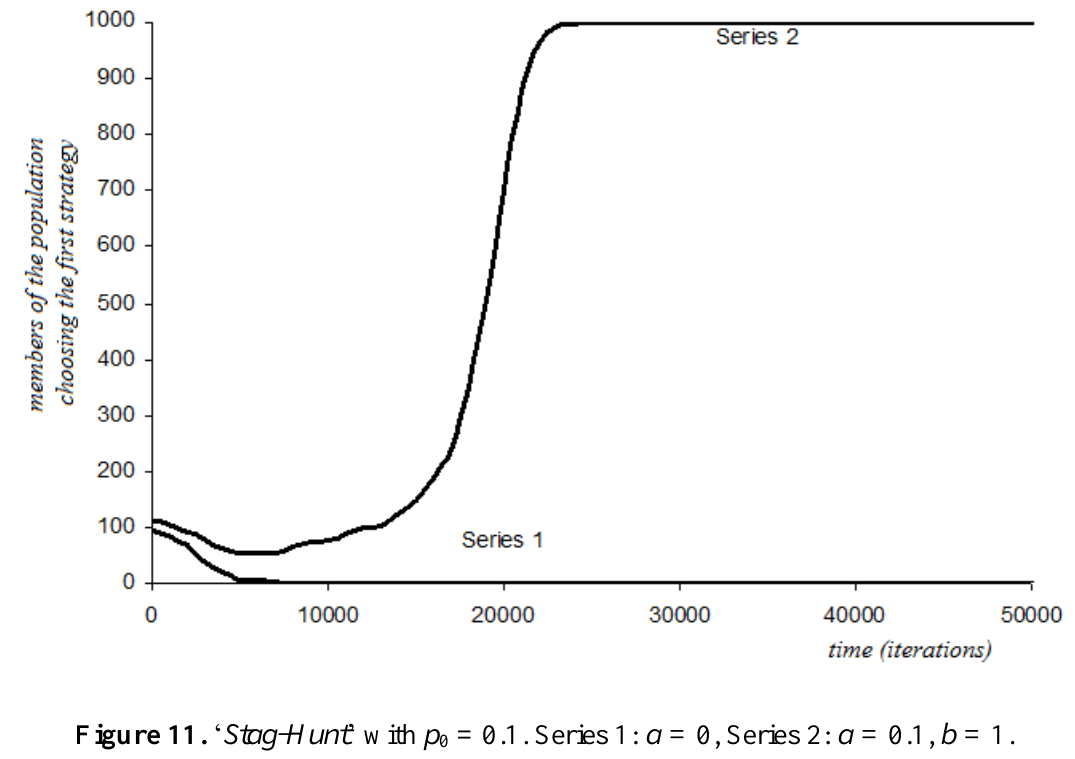
= 0.1. Series 1: a = 0, Series 2: a = 0.05, b = 1. 0